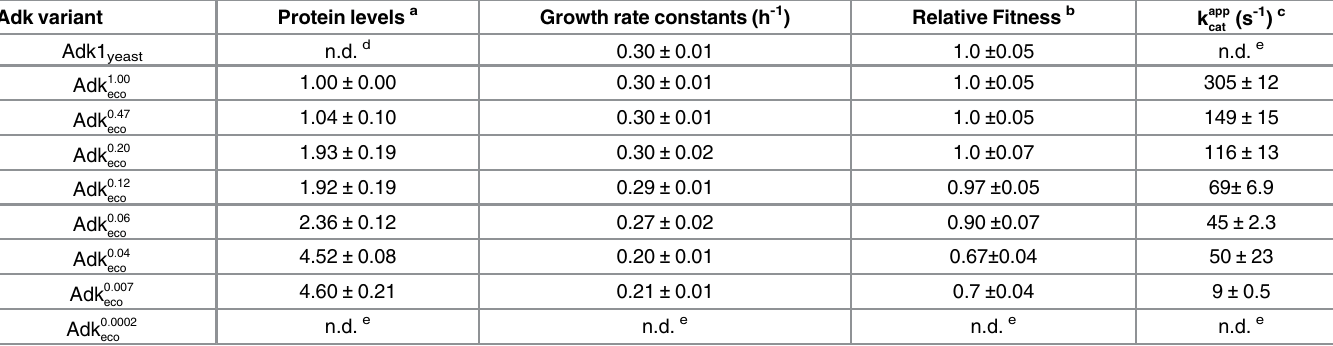
Table 2. Expression levels, growth rate constants, relative fitness and apparent k cat values of Adk eco variants at 20°C.